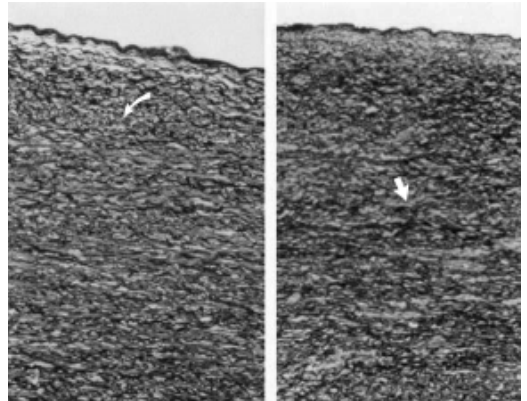
Fig. 2A and 2B - On the left (2A) transversal histological section of the ascending aorta of a 54-year-old male patient with tricuspid aortic valve. Note the small areas with changes in the direction of the smooth muscle cells (arrow) and a slight accumulation of mucopolysaccharides. On the right (2B), transversal histological section of the ascending aorta of a 33-year-old male patient with tricuspid aortic valve and aortic involvement. Note the intense disorganization of the elastic tissue and a great accumulation of mucopolysaccharides (arrow) in all the media layer (cystic necrosis of the media). Staining method: Movat pentachromic stain. Magnification: 100 x.